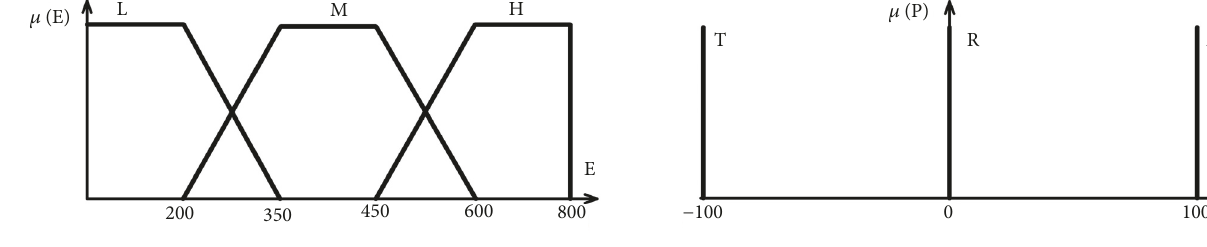
Figure 5: Membership functions for the call acceptance. Definition of the membership functions: T: transfer; R: reject; A: